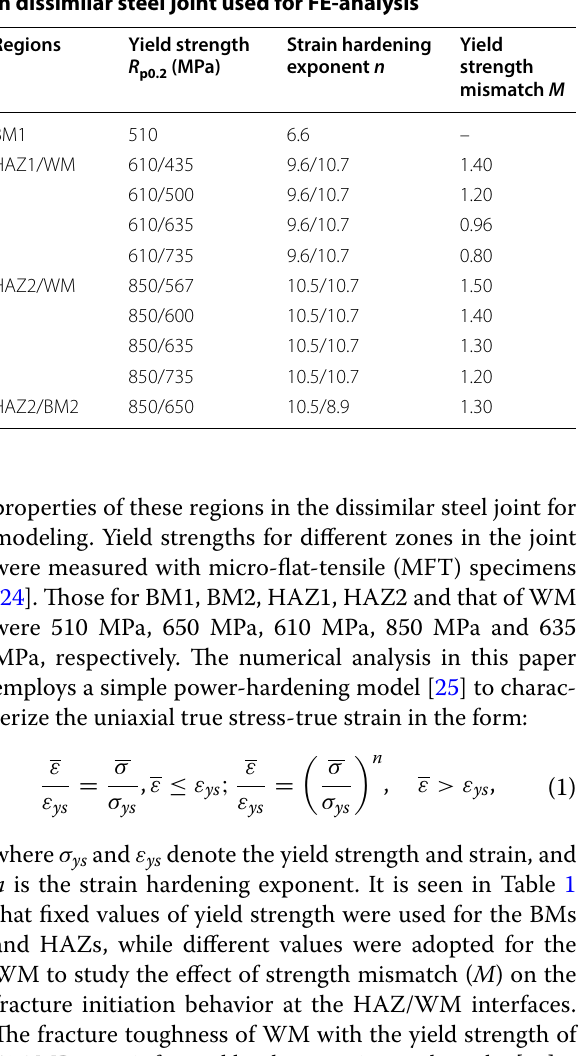
Table 1 Mechanical properties of BMs, WM and